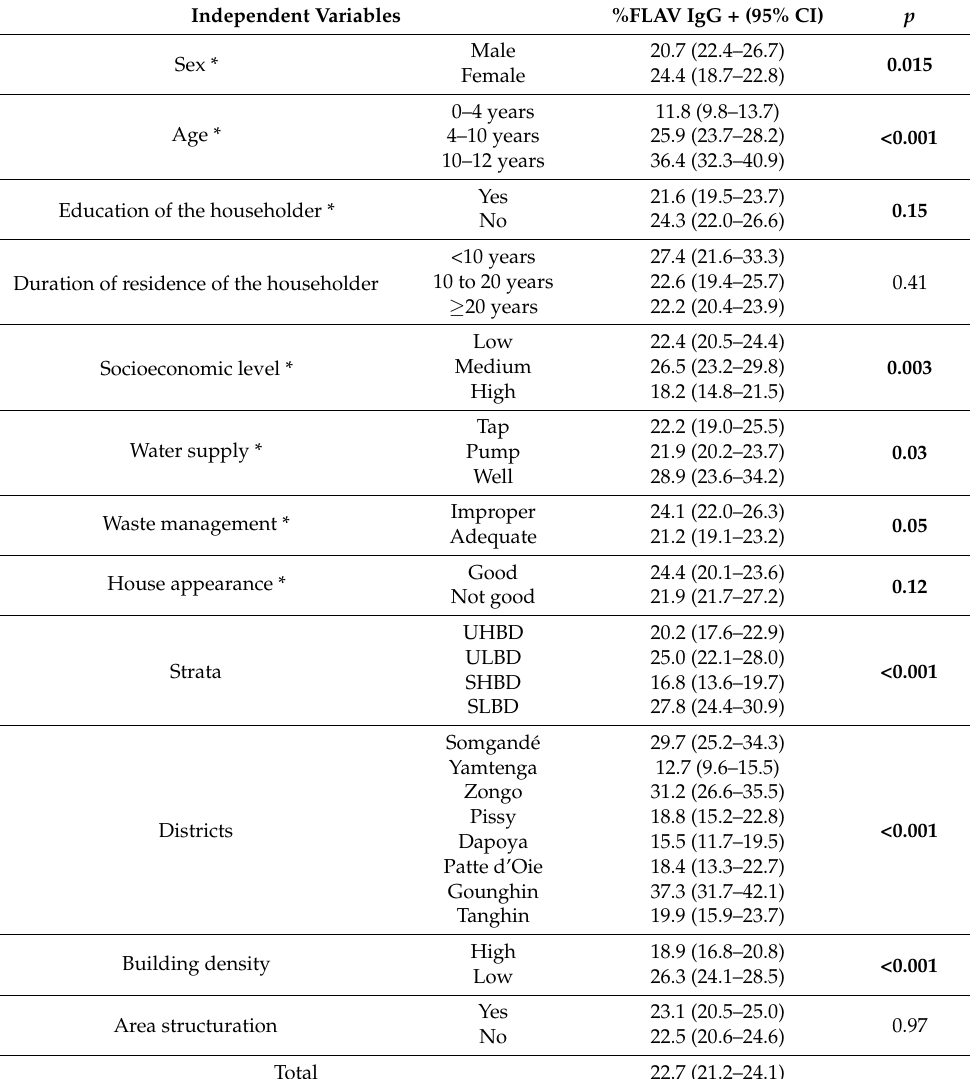
Table 2. Apparent prevalence of previous flavivirus infections according to individual, household and environmental